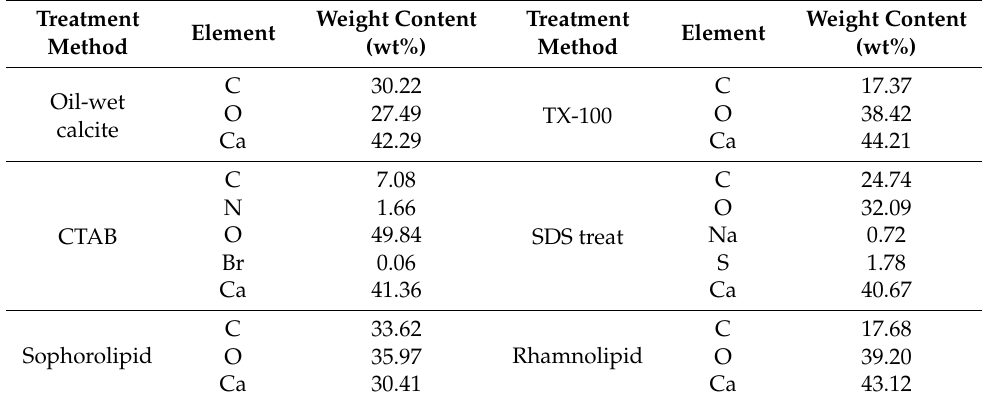
Table 3. EDS analysis of figures of oil-wet calcite modified with five surfactants.